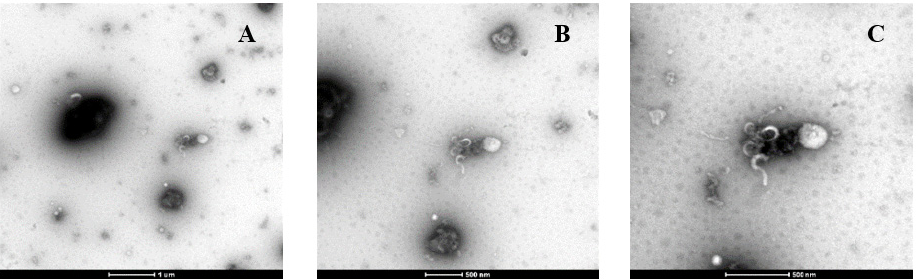
Figure 5. Transmission electron micrographs of the kiwifruit juice containing the double-layer liposomes at different magnification: ( A ) 16,500×, ( B ) 26,500×, and ( C ) 43,000×.